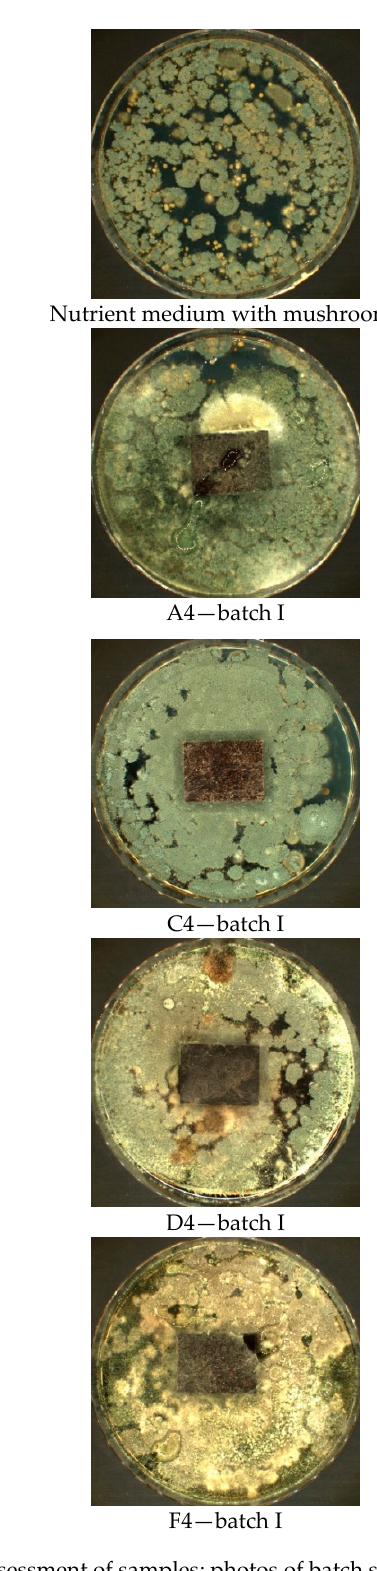
Figure 5. Method B’—results of visual assessment of samples; photos of batch samples: I.